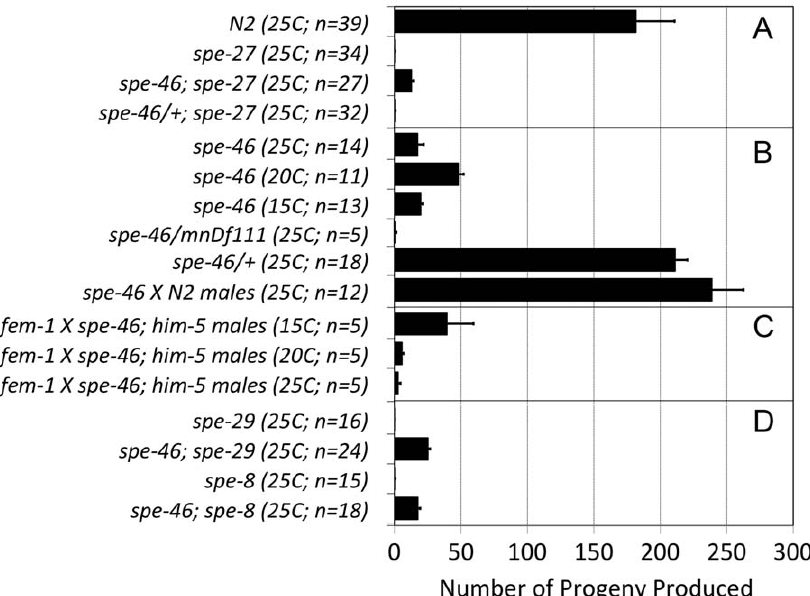
Figure 7. The number of progeny associated with the spe-46(hc197) mutation. (A) Hermaphrodite self-progeny showing that spe-46(hc197) is a recessive suppressor of spe-27(it132) sterility. (B) In an otherwise wild-type background, selfing spe-46 hermaphrodites exhibit a conditional spermatogenesis defect that is rescued by mating with N2 males. Further, the spe-46 defect is recessive. (C) Male spe-46 mutant worms display a temperature-sensitive sperm defect when mating with spermless fem-1(hc17ts) hermaphrodites, being most fertile at 15 u C. Finally, (D) the spe-